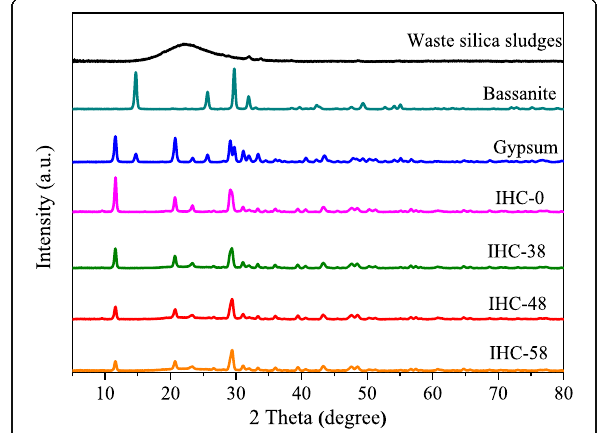
Fig. 2 XRD patterns of waste silica sludges, bassanite,